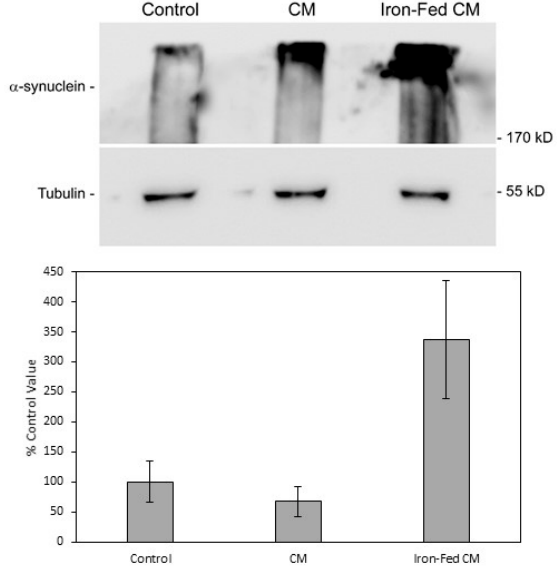
Figure 12. Aggregation of α -syn. Western blot was used to detect high molecular weight aggregates of α -syn in extracts from SH-SY5Y cells treated with conditioned medium from primary microglia. SH-SY5Y cells were treated for 24 h with medium from control microglia (CM) or iron-fed microglia (Iron-Fed CM). Some cells were treated with just serum free medium (control). Extracts were prepared and electrophoresed on a 6% PAGE gel. The protein was then transferred by blot to a PVDF membrane (3 h, 100 mA) and α -syn detected with a specific antibody. High molecular weight bands for α -syn were indicative of aggregates. We also verified protein loading by re-probing the same blots for tubulin. Bands for α -syn were then analysed densitometrically. Values for control were normalised to 100% and values for the treated samples compared. Only treatment with iron-fed conditioned medium caused a significant ( p < 0.05) increase in α -syn detected in the aggregate band. Shown are the mean and S.E.M. for four separate